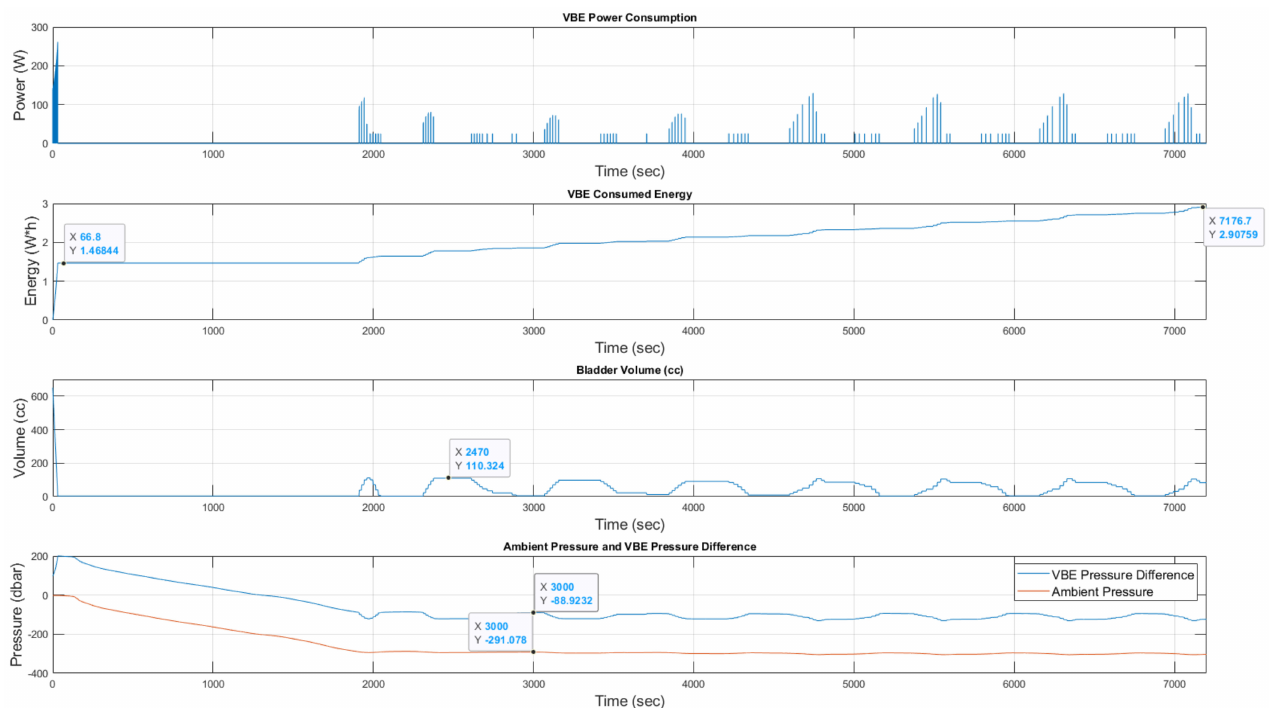
Figure 14. Simulink power simulation #1: no pressure assistance; HPA minimum pressure equal 0 bar gauge.